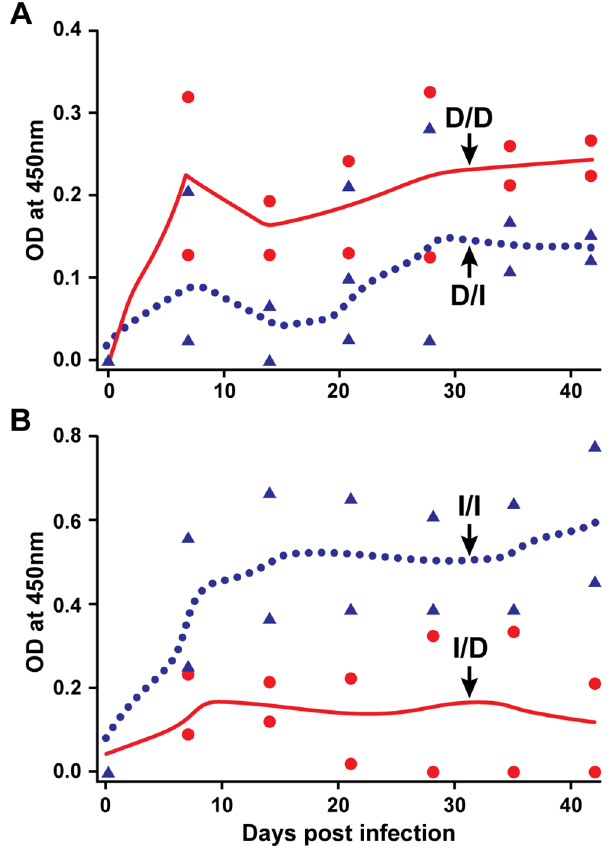
Figure 6. E.chaffeensis -specific IgG response in dogs receiving infection by i.v. with DH82 culture-derived inoculum (A) or i.v. with ISE6 culture-derived organisms (B). Black circle data points and black line (polynomial smoothened line) in panel A refer to IgG data for DH82 culture infected animals using DH82 culture-derived antigens (D/D), while the black triangles and dotted line represent IgG response data generated with ISE6 culture-derived antigens (D/I). Panel B; as in A, except that the dogs in this group were infected with ISE6 culture- derived inoculum and antigens used in the ELISA analysis are either from derived from DH82 (I/D) (black circle data points and black line) or ISE6 (I/I) (black triangles and dotted line) cells. The Y-axis scales differ between charts.